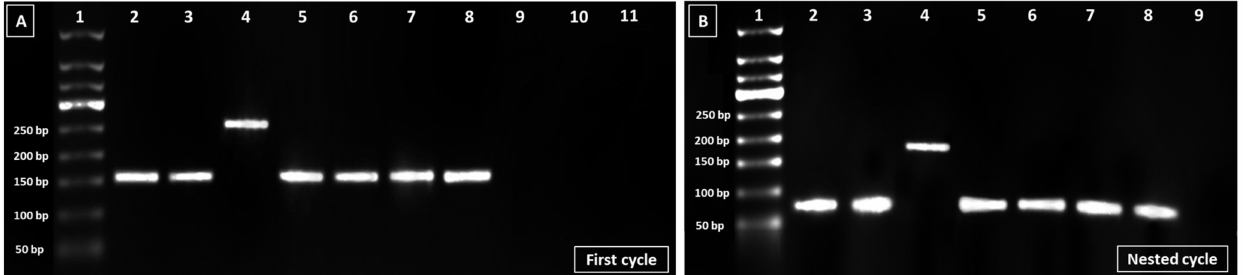
Figure 3. ( A ) First round PCR product of EBNA-3C gene. Lane 1 is a 500 bp DNA Ladder (50–500